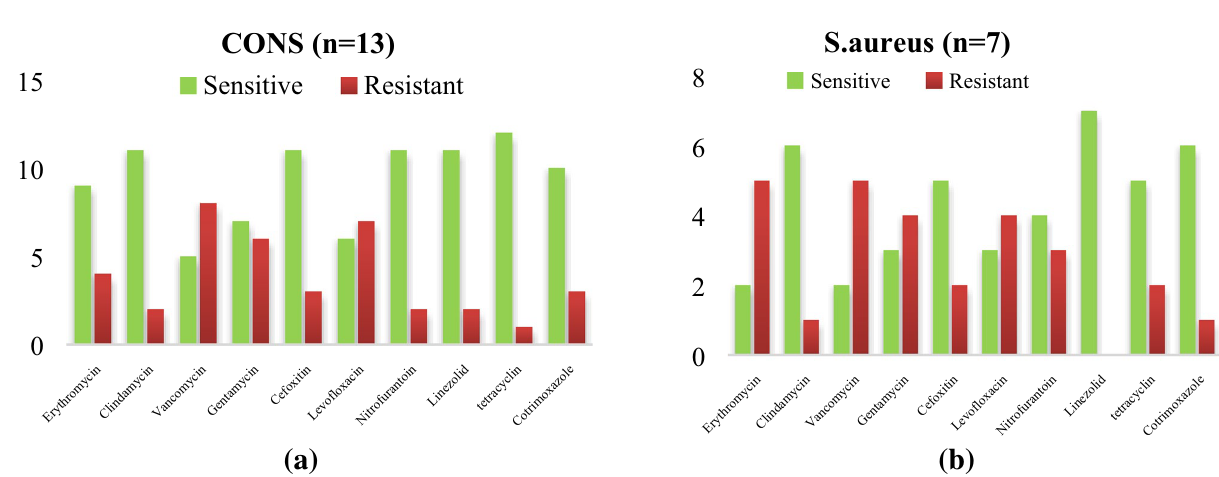
Figure 7. ( a ) Antibiogram of Acinetobacter spp. isolated from medical devices in NICU. ( b ) Antibiogram of Enterococcus faecalis isolated from medical devices in NICU. Acinetobacter spp., were least resistance to colistin (2/8) imipenem (8/8 ), Enterococcus faecalis shows more sensitivity towards Tigecycline (5/5) followed by linezolid (3/5).